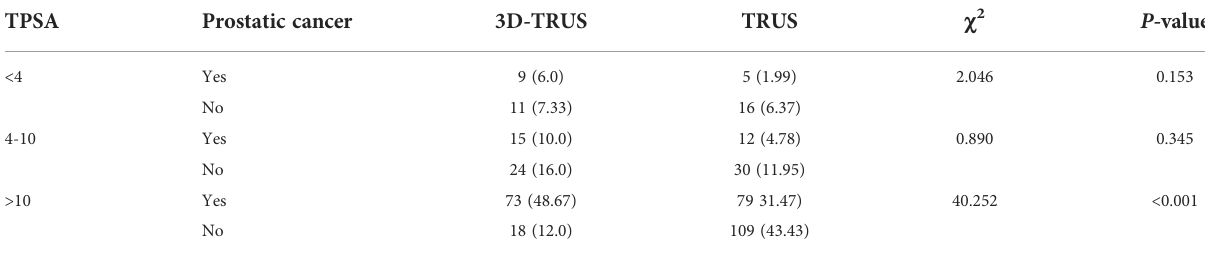
TABLE 8 The relationship of TPSA and detection rate of prostatic